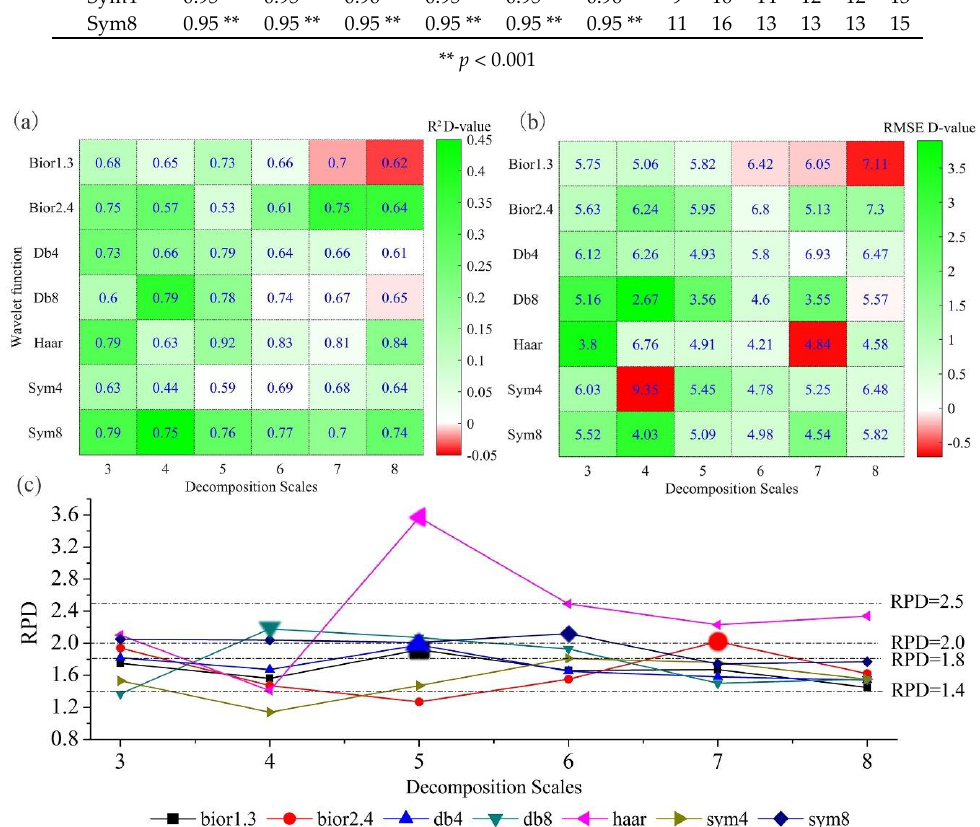
Figure 7. R v 2 (numbers in grid squares) and R 2 difference value (D-value) (color bar) between DWT–Stepwise-PLS and DWT–PLS ( a ), RMSE (numbers in grid squares) and RMSE D-value (color bar) between DWT–Stepwise-PLS and DWT–PLS ( b ), and RPD between the laboratory-measured CEC and the DWT–Stepwise-PLS predictions on the CEC validation data set ( c ).